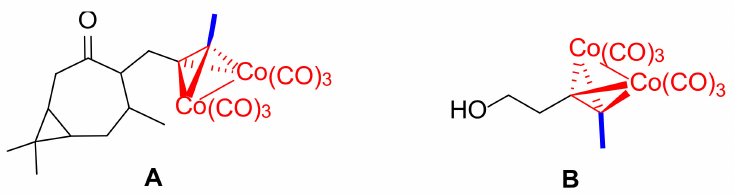
Figure 5. Presentation of the two structurally characterized dicobaltatetrahedranes ( A ) and ( B ) incorporating a -CH 2 -C ≡ C-Me motif. Table 1. Comparison of relevant bond lengths (Å) and angles ( ◦ ) in 2 and the